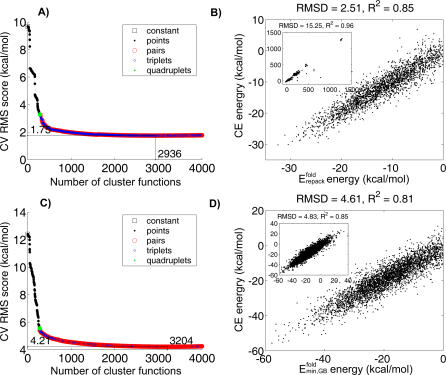
Cluster Expansion of Zinc-Finger Energies(A) and (B) refer to the CE of

; in (C) and (D),

was used.
(A) and (C) represent the evolution of the CV score (the progress of the fit) as the number of CFs was increased, with the type of CF added at each point (i.e., constant, point, pair, triplet, or quadruplet) indicated by color. The ordering of the points is described in Materials and Methods. The set of CFs and ECI used in the final expansion was taken from the point with the minimal CV score, which is indicated on the graphs.(B) and (D) show the performance of the respective CEs on predicting energies of 4,000 random sequences not included in the training sets. Insets show the entire range of energies, whereas only sequences with reasonably low energies are shown in the main plots.